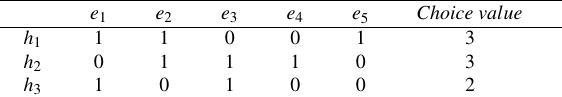
Table 5: Tabular representation of L (( F , A ) , 0 . 62 ) with choice values